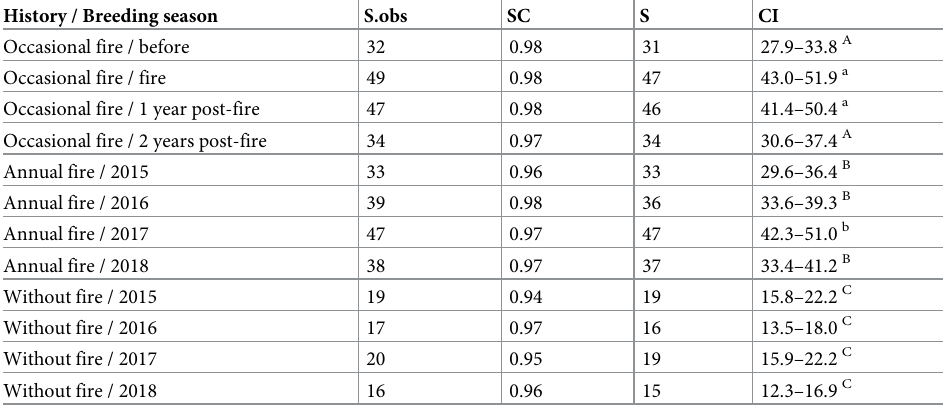
Table 1. Bird richness in areas with different histories of fire disturbance during four breeding seasons (2015– 2018) in highland grasslands in northeastern Rio Grande do Sul state, Brazil.